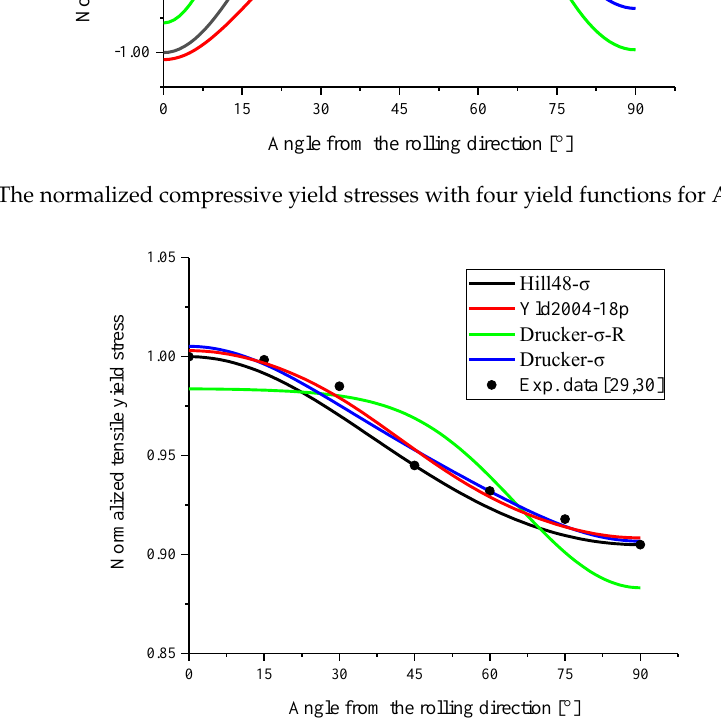
Figure 5. The normalized tensile yield stresses with four yield functions for AA 2008-T4 sheet.